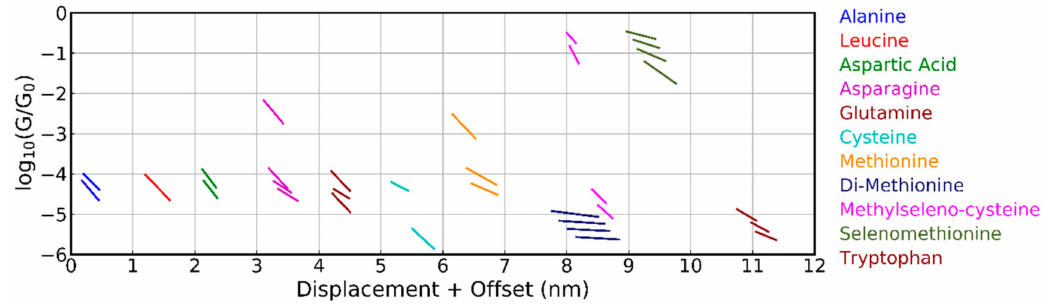
Figure 4. Overview of the average conductance plateaus for all amino acids measured with the MCBJ, obtained from the clustering analysis into five classes. Plateaus are only shown, if they are shorter than the molecule and less steep than the tunneling slope. The plateau positions for subsequent molecules are o ff set by 1 nm in the horizontal displacement